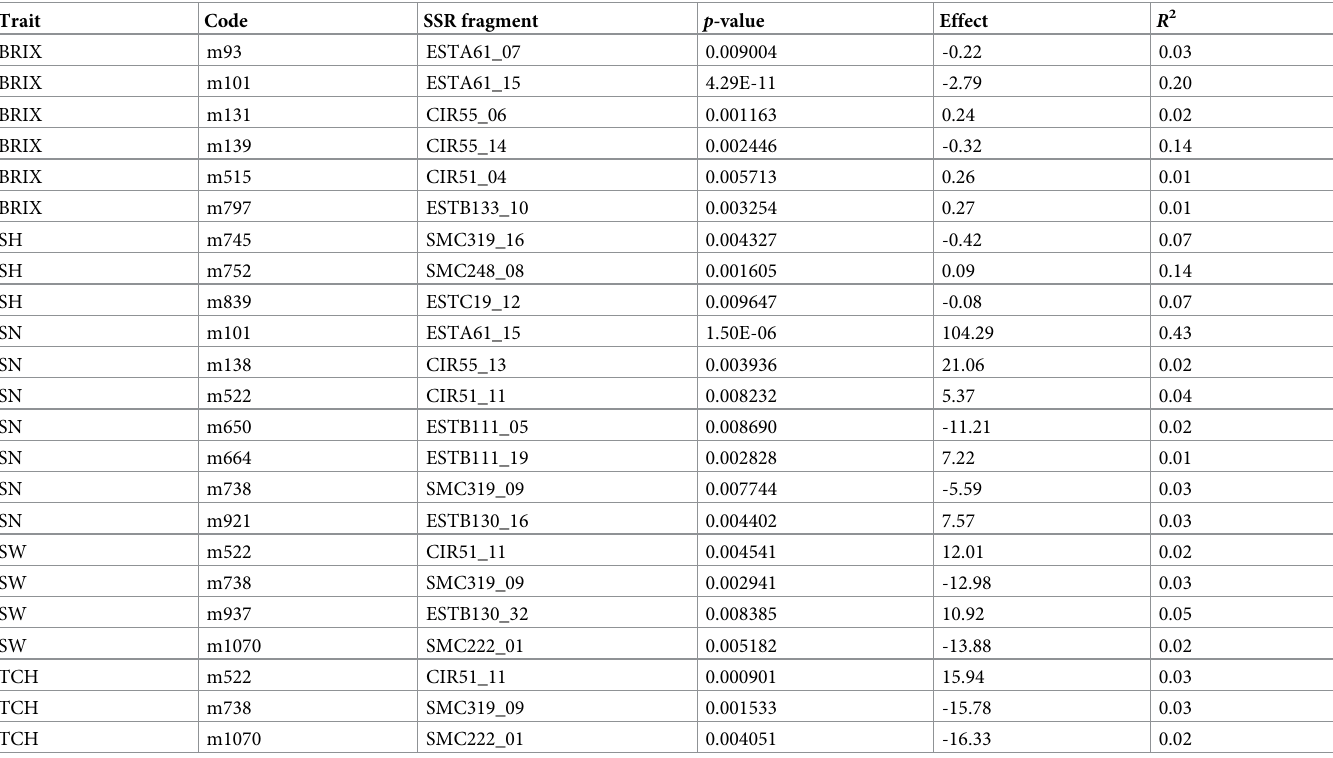
Table 2. BRIX, SH, SN, SW and TCH MTAs, p -values, effect estimates and amounts of phenotypic variance explained (adjusted R-squared) when using the MLMM implemented in FarmCPU.